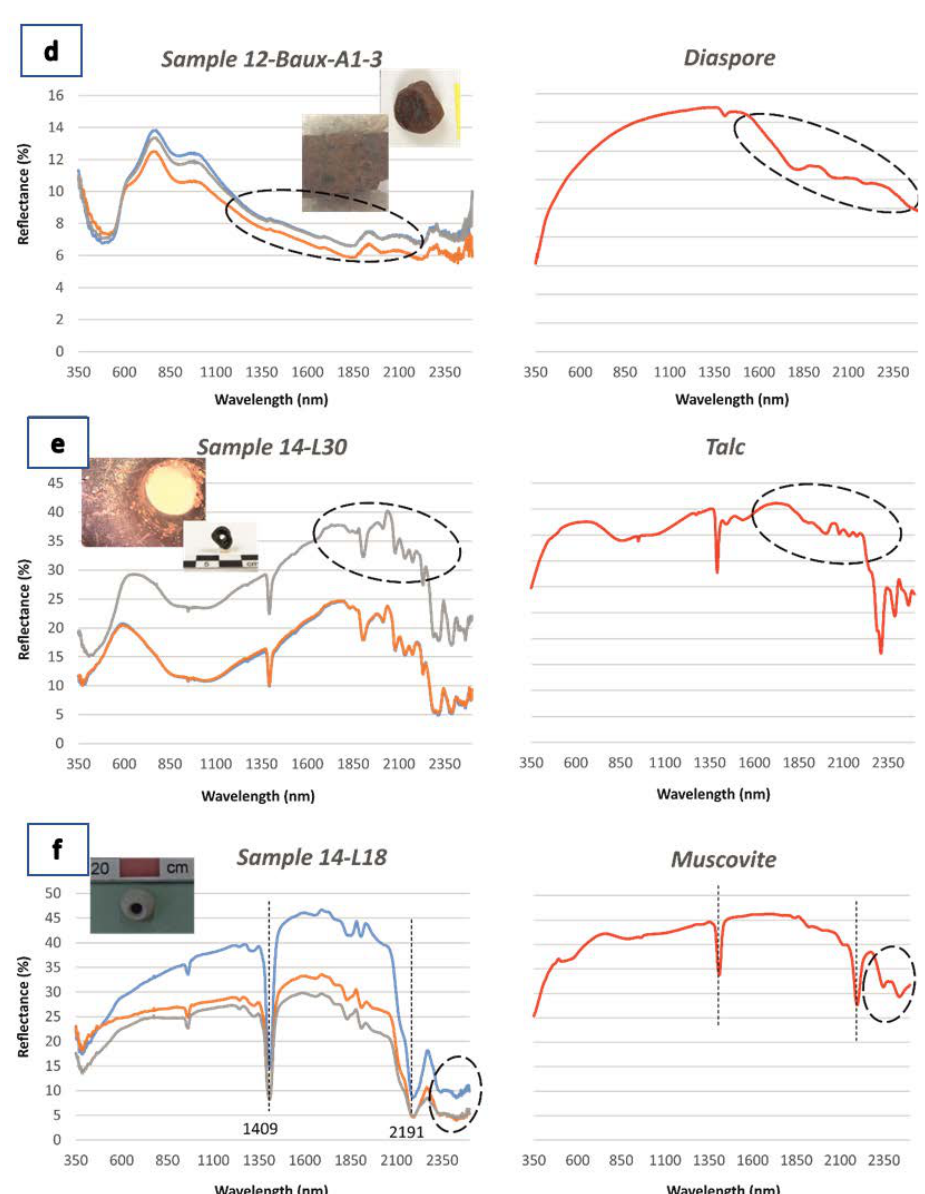
Figure 7. Representative reflectance spectra of the studied stone artefacts (left column), in comparison to the associated laboratory reference, spectra of the USGS spectral library (right column) that were used in the present study [39]: ( a ) pebble; ( b ) bifacial geometric tool; ( c ) floater; ( d ) rubber; ( e ) and ( f ) bead.